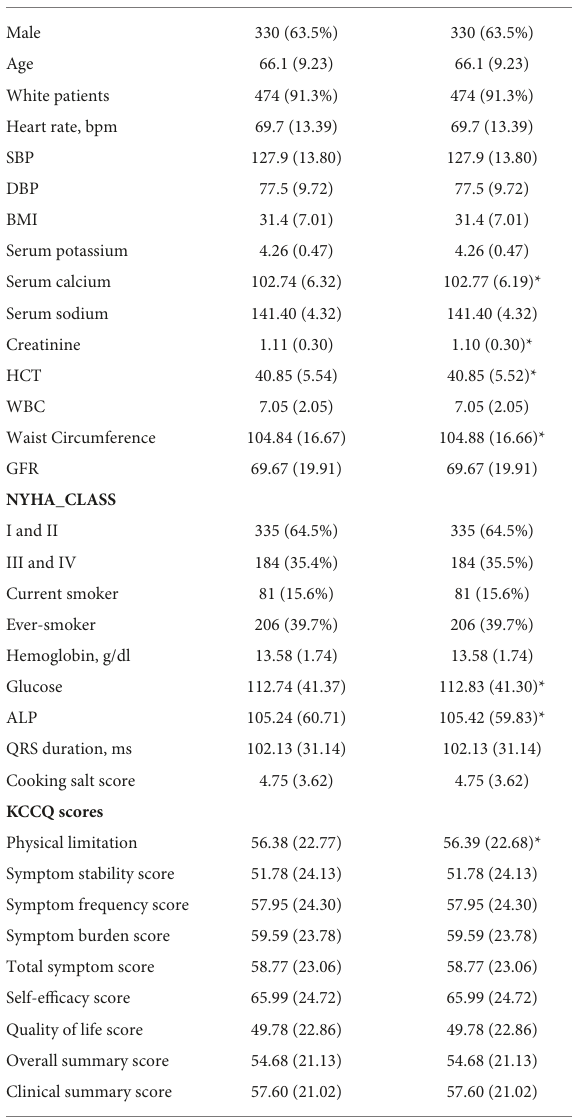
TABLE 1 Baseline characteristics of patients ( N =